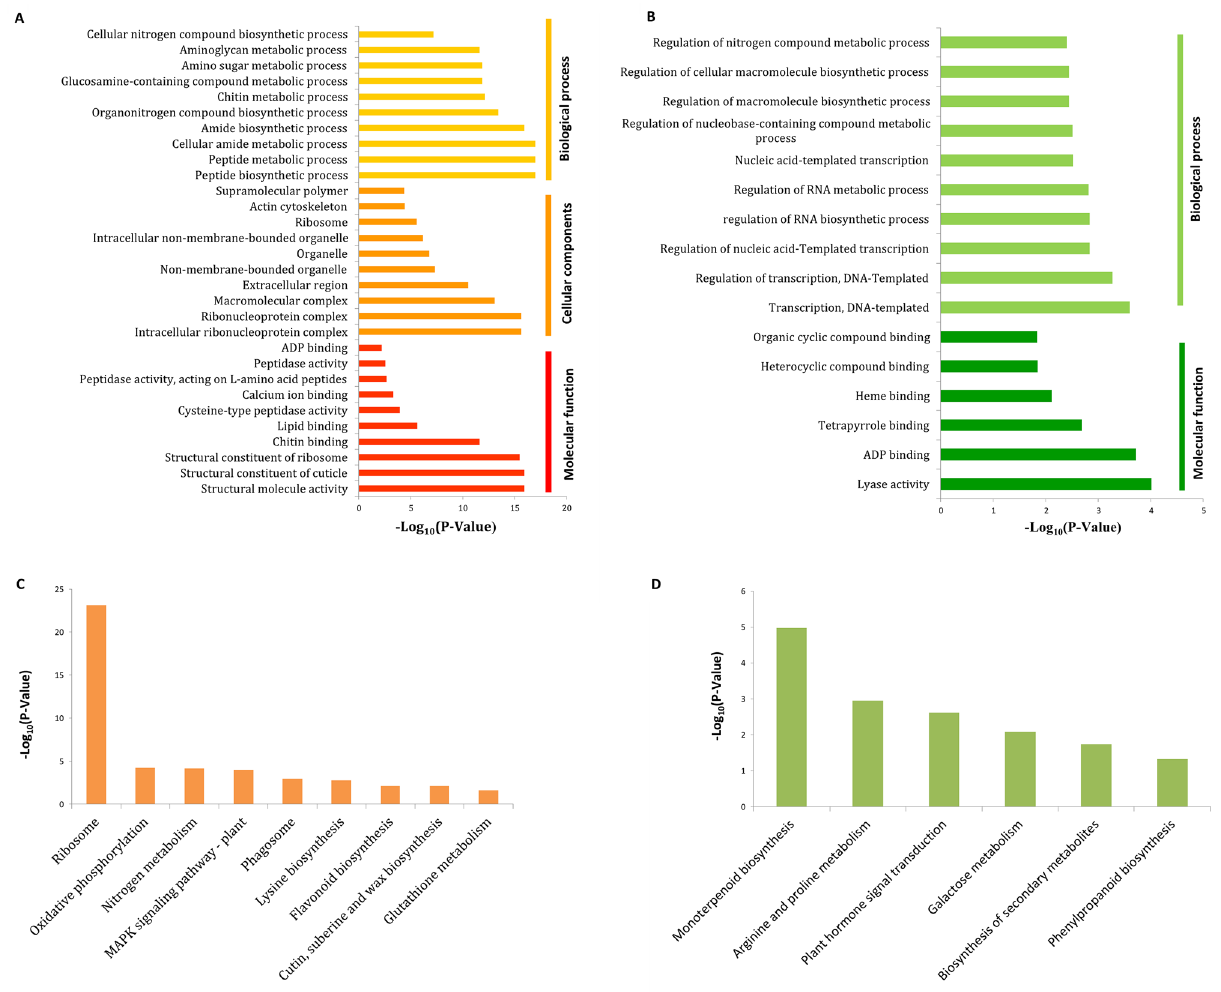
Figure 3. The main results of differential gene enrichment analysis. The TOP 10 significantly enriched GO terms in each main categories for ( A ) up and ( B ) down-regulated genes (or be short of 10 terms). Significantly enriched KEGG pathways for ( C ) up and ( D ) down-regulated